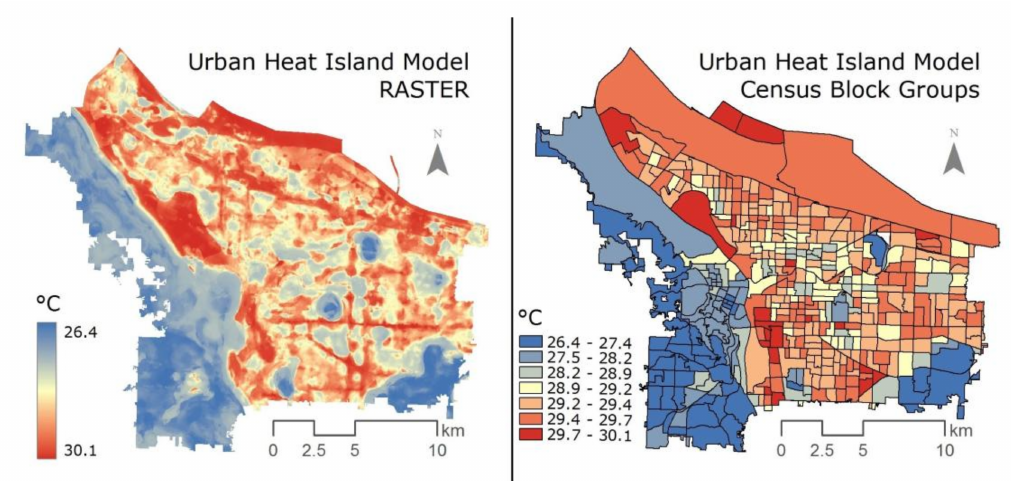
Figure 1. Comparison of the original raster format of the distribution of ambient urban heat ( left ) and the transformed block group-based urban heat dataset ( right